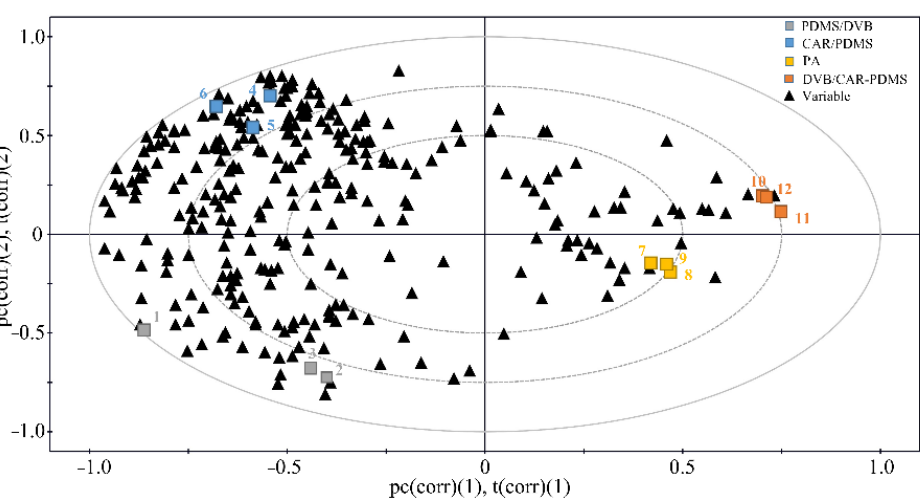
Figure 2. Score-loading biplot of GC × GC/TOF-MS data from the PLS model of Chinese liquor showed the correlation among fibers and the area of 292 compounds. Typical data points representing the experimental solid-phase microextraction fiber. Colorized box representing different fibers and black triangles representing the area of 292 compounds. Each SPME experiment was triplicated.